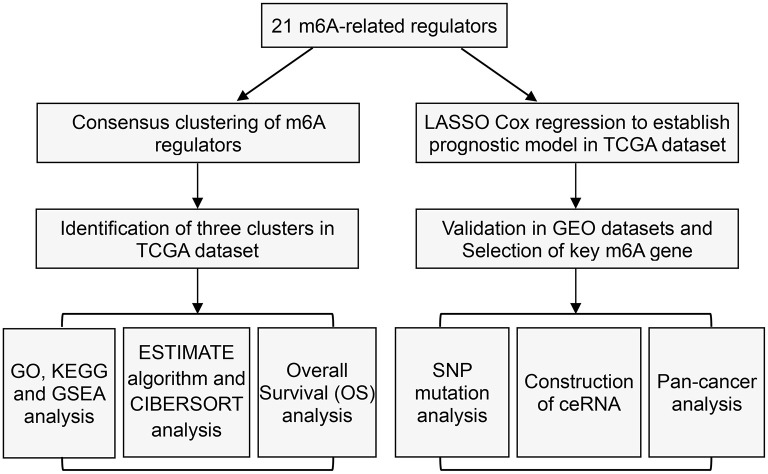
Study flow chart.